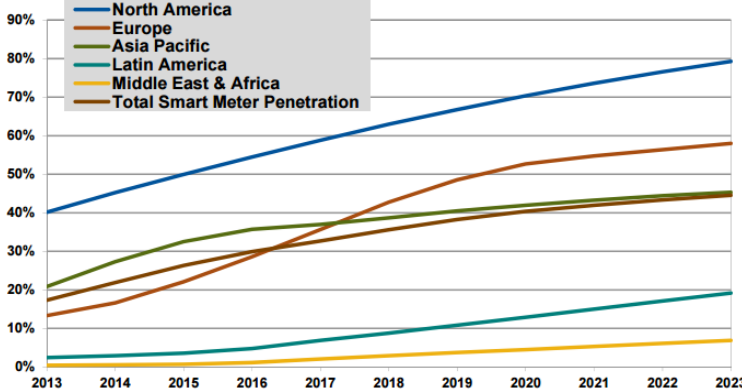
Figure 3. Evolution of SM deployment worldwide (Source: Navigant Research [45]). Reprinted with the permission of Navigant Research, “Smart Electric Meters, Advanced Metering Infrastructure, and Meter Communications: Global Market Analysis and Forecasts” published by Navigant Research, 2014.